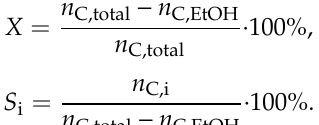
. = 5 L / h). Error bars have V N = 5 l/h). Error bars have been omitted (cid:3118) 2